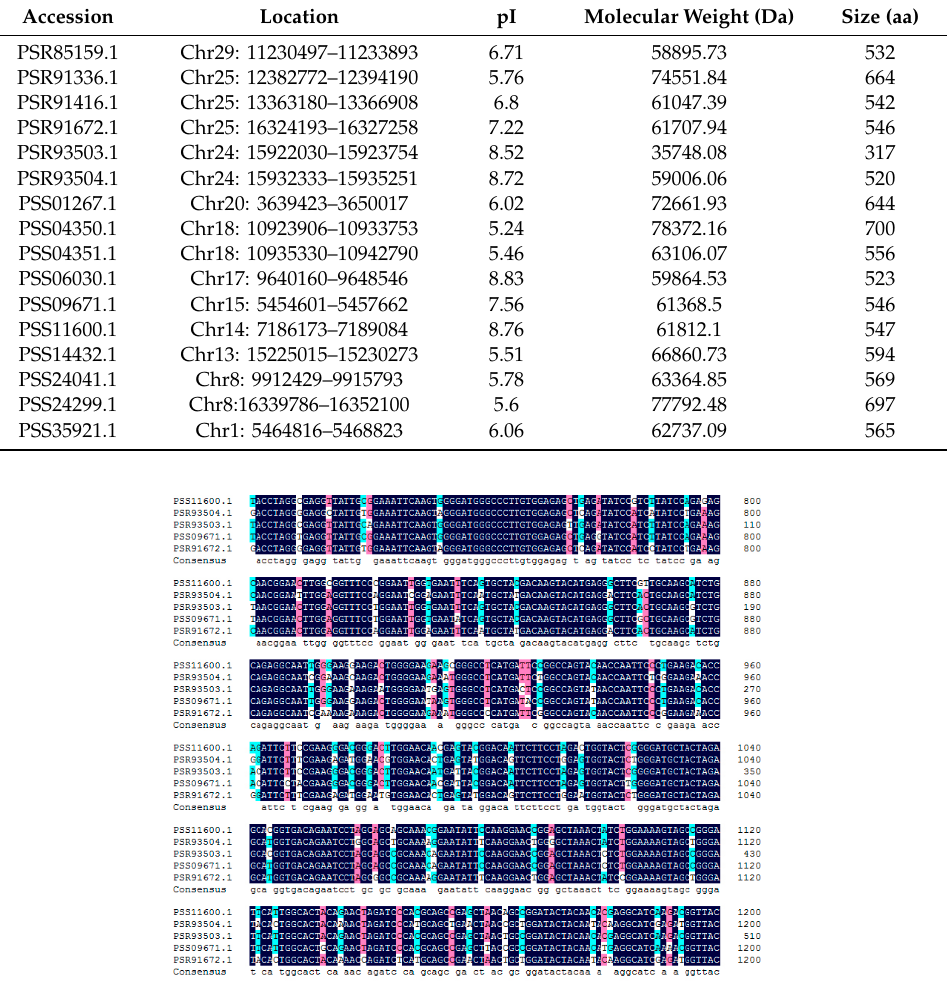
Figure 7. Alignment of the core sequence of part AcBAMs and their consensus sequences.